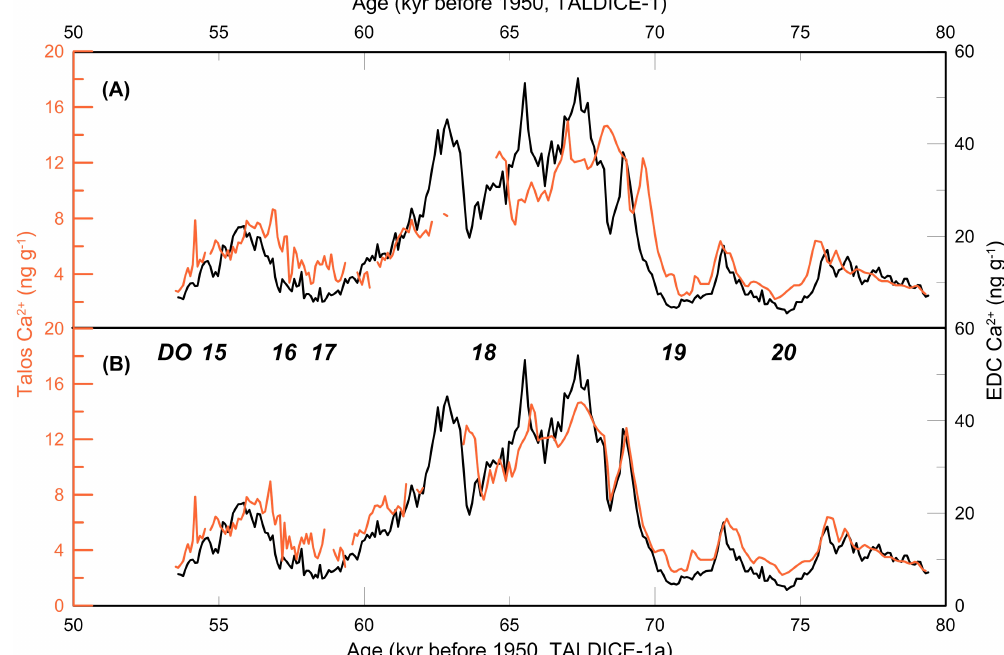
Fig. 5. The Ca 2 + records from EDC (black line, Bigler et al., 2006) on the EDC3 age scale and from TALDICE (orange line, new data) on the original TALDICE-1 age scale (A) and the refined TALDICE-1a age scale (B) , respectively, are compared on the interval from 54–80 ka BP. EDC data are shown as 1 m averages, TALDICE data as 50 cm averages. TALDICE data are interpolated to fit the EDC data at the respective ages. Bold italic numbers indicate Dansgaard-Oeschger (DO)